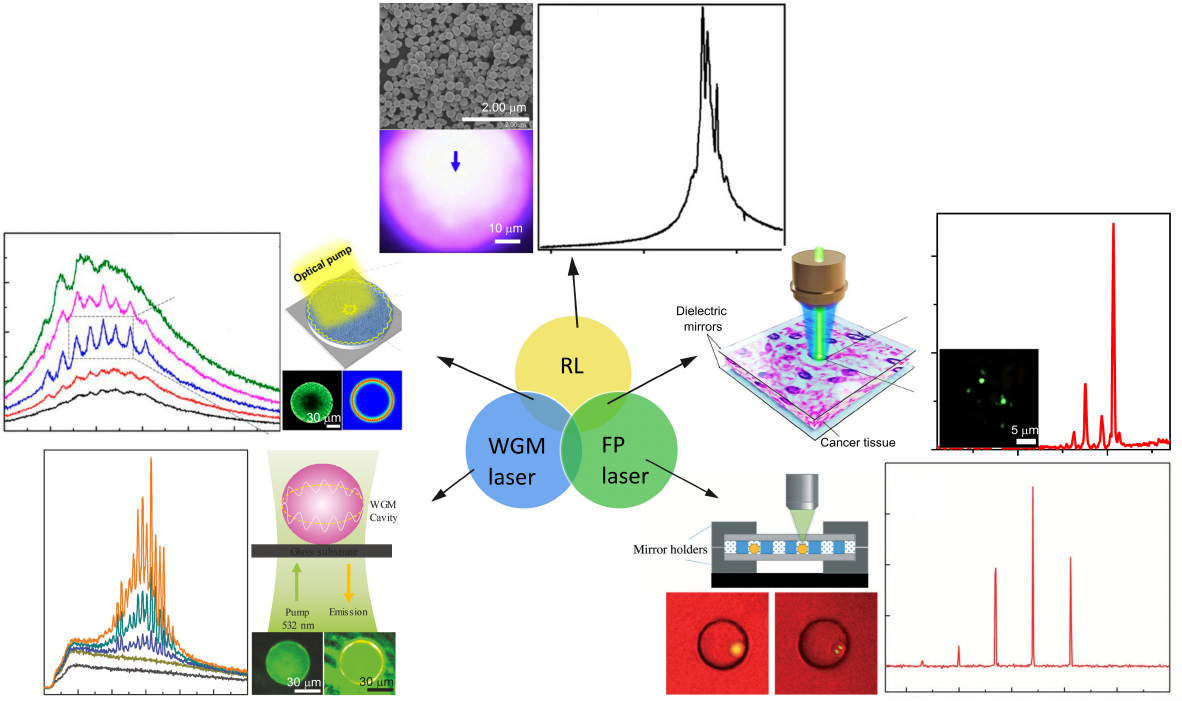
Figure 1. Different optical feedback mechanisms in RL, WGM laser and FP laser. The corresponding setups, lasing cavities and typical lasing spectra are shown beside. RL: top. Adapted from Ref. [35] with permission from IOP Publishing under CC BY 3.0 license. WGM laser: left bottom. Adapted from Ref. [36] with permission from WILEY-VCH under CC BY 4.0 license. FP laser: right bottom. Adapted from Ref. [37] with permission from Royal Society of Chemistry. RL in combination with WGM laser: left top. Adapted from Ref. [38] with permission from MDPI under CC BY 4.0 license. RL in combination with FP laser: right top. Adapted from Ref. [39] with permission from Springer